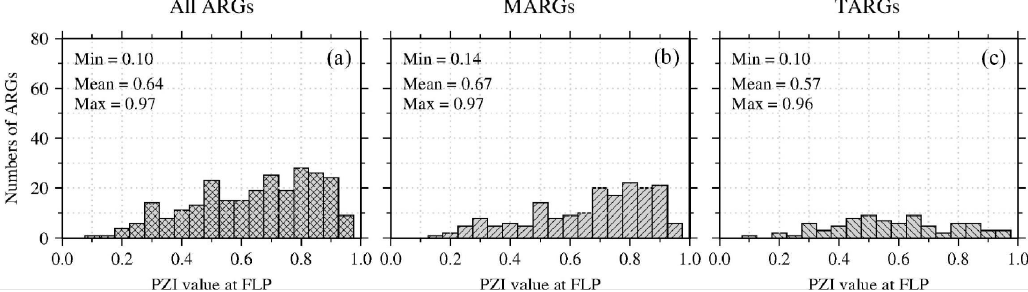
Figure 11. The histograms of the PZI values at the front line point (FLP) for all ARGs (a) , MARGs (b) , and TARGs (c) , respectively.